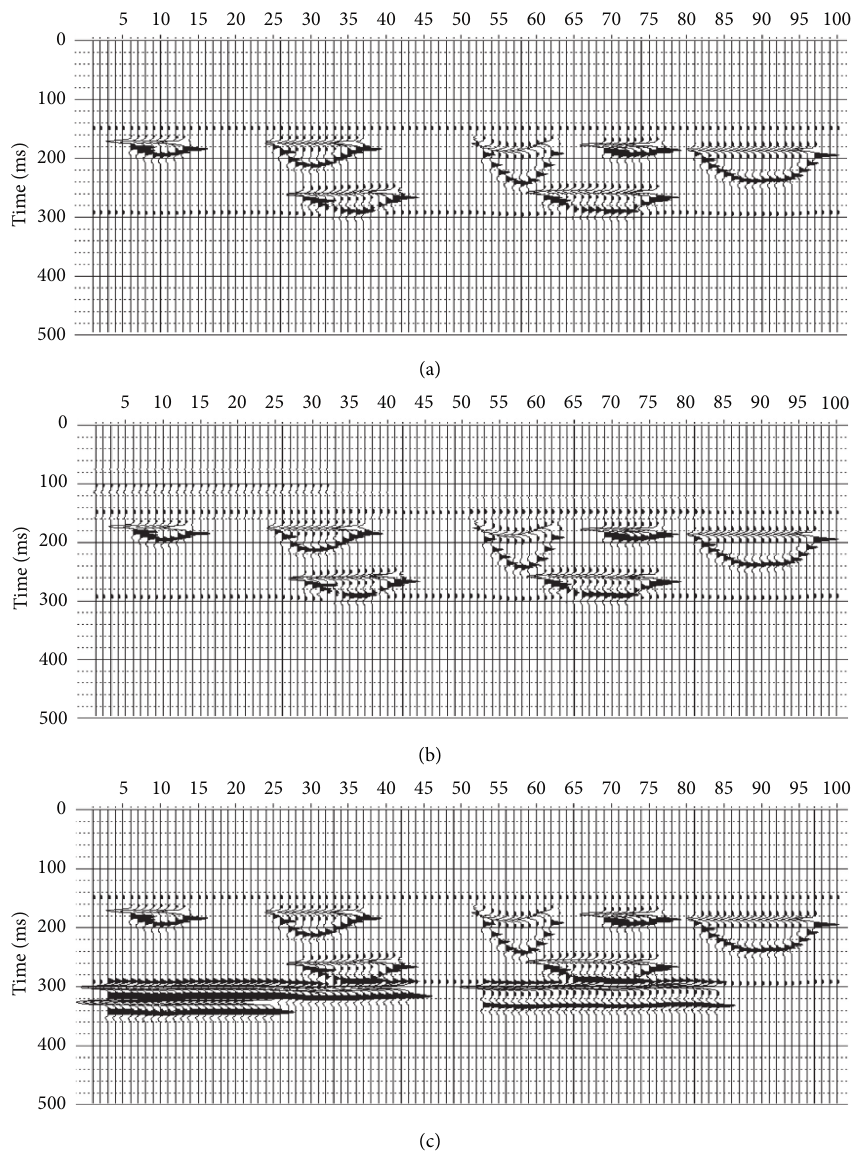
Figure 6: Synthetic seismic records of different 2D channel geological models at 40Hz. (a) Noninterference. (b) Upper interference. (c) Lower